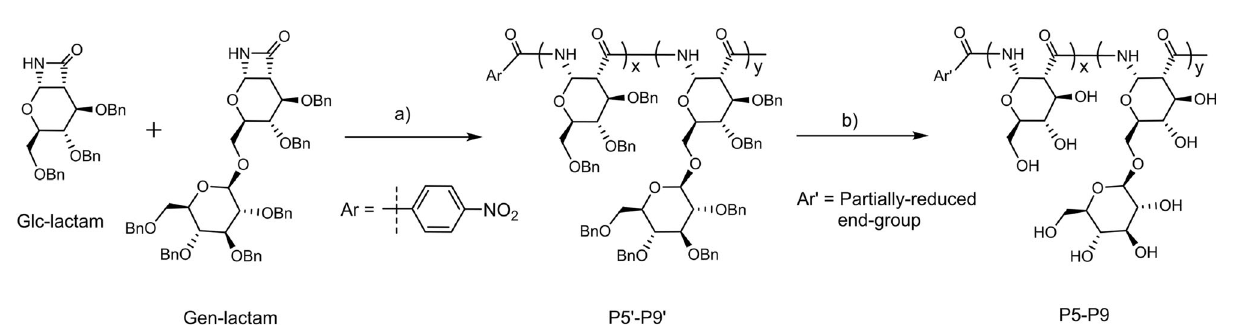
Fig. 4 | Synthesis of (1 → 6)- β -glucose branchedPASs by copolymerization ofGen-lactam with Glc-lactam. Reagents and conditions: a 4-NO 2 BzCl, LiHMDS, THF, 0°C, yield: 84 – 91%; b Na, NH 3 ( l ), − 60°C, yield: 80 – 92%.